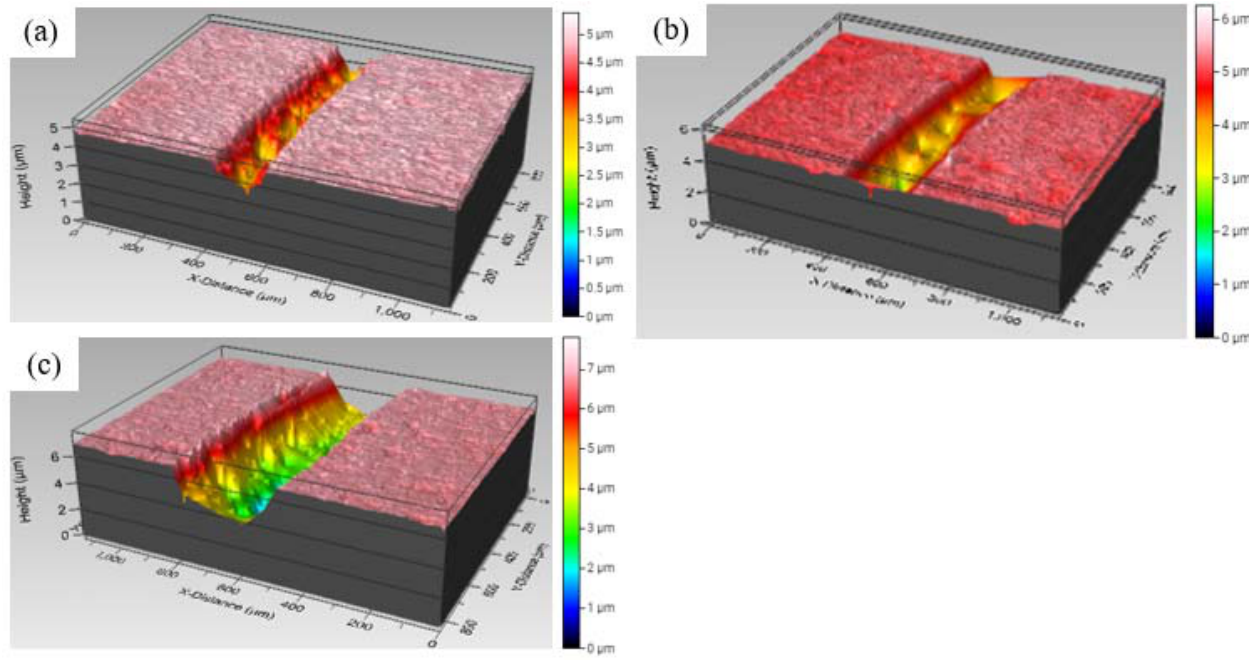
Figure 10. Three ‐ dimensional profilometer wear track images for ( a ) P 700/600°C , ( b ) P 700/800°C and ( c ) Figure 10. Three-dimensional profilometer wear track images for ( a ) P 700/600 ◦ C , ( b ) P 700/800 ◦ C and P 700/1000°C. ( c ) P 700/1000 ◦ C